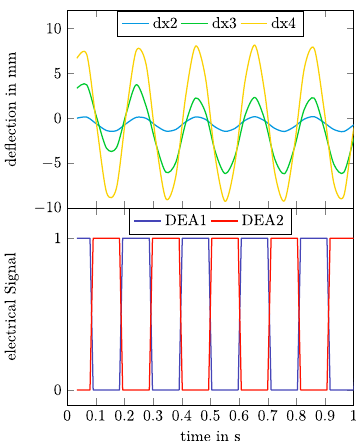
Figure 13. Exemplary deflection results for a switching frequency of 5 Hz. Overview of the electrical switching regime and the caused deflections dx2, dx3, and